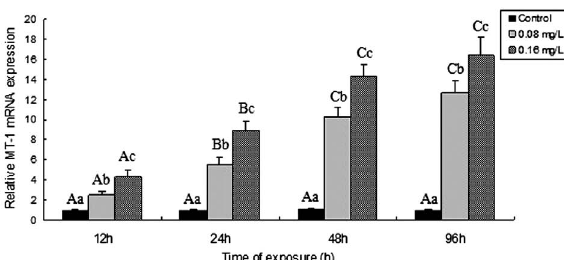
Fig. 3. – MT-1 mRNA expression in megalopa larvae after copper treatment (0, 0.08 mg L –1 , 0.16 mg L –1 ). Expression was determined by real-time quantitative RT-PCR. Values are means ±SE ( n =4). MT-1 expression was normalized to β -actin expression. Bars with different letters differed significantly (P < 0.05). Different lowercase letters indicate significant differences between the treatment and control groups for each exposure time. Different capital letters indi- cate significant differences between different exposure times for the same copper concentrations.